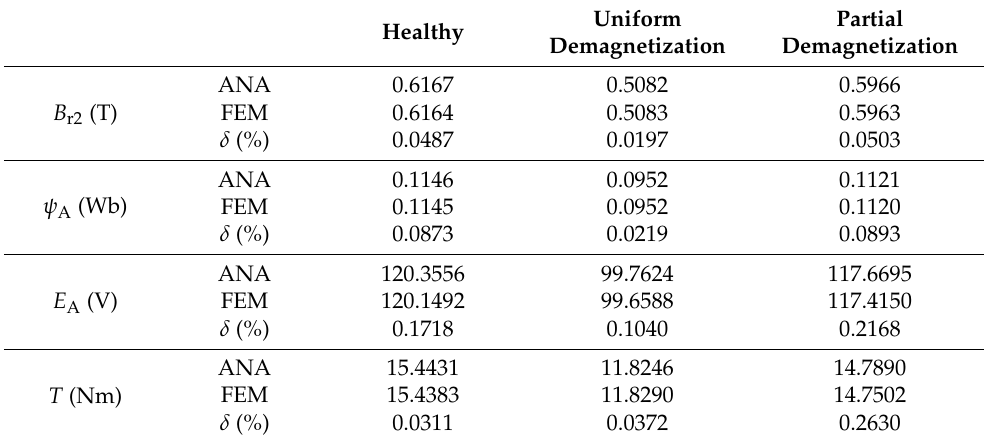
Table 5. Comparison of RMS and error for PM motor with parallel magnetized